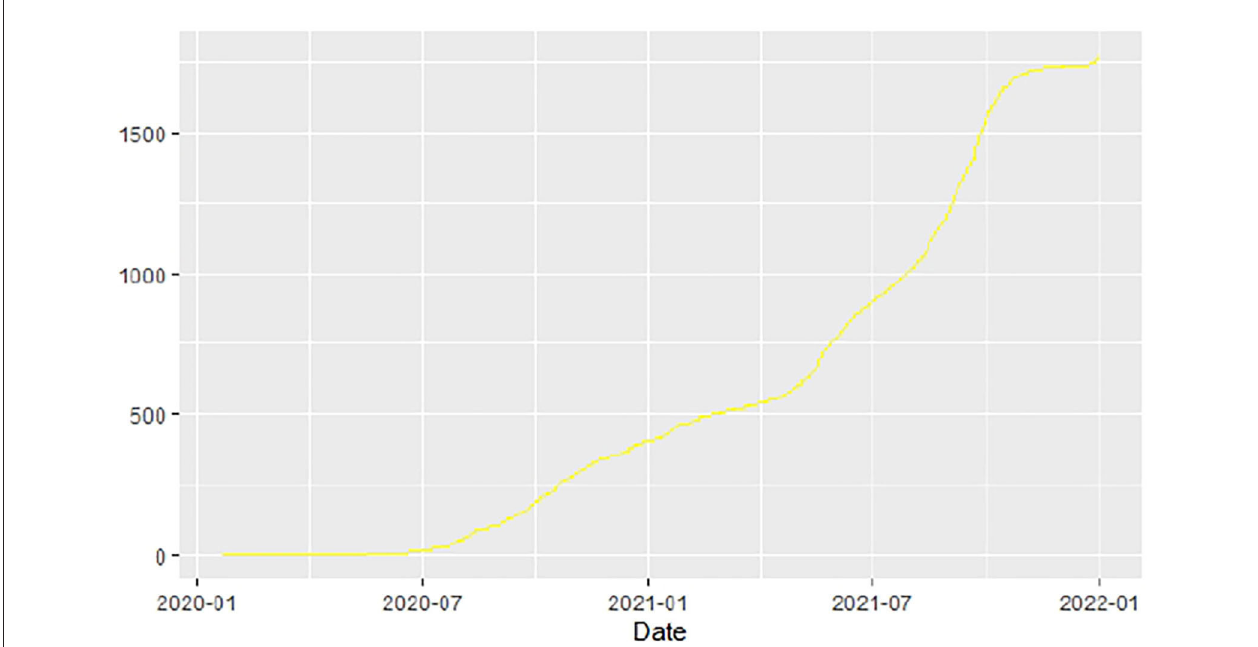
FIGURE 11 | Angola deaths.